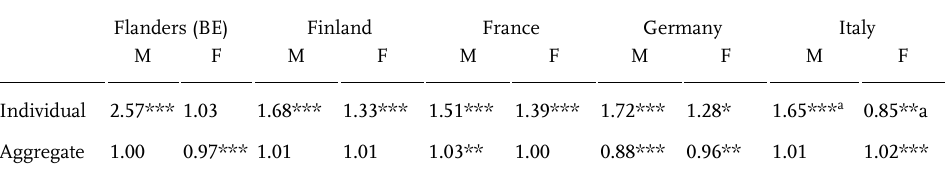
Table 2 : Individual and macro-economic effects of unemployment for men (M) and women (F), discrete-time models on the dissolution risk, odds ratios Flanders (BE) Finland France Germany Italy M F M F M F M F M F Individual 2.57*** 1.03 1.68*** 1.33*** 1.51*** 1.39*** 1.72*** 1.28* 1.65*** a 0.85**a Aggregate 1.00 0.97*** 1.01